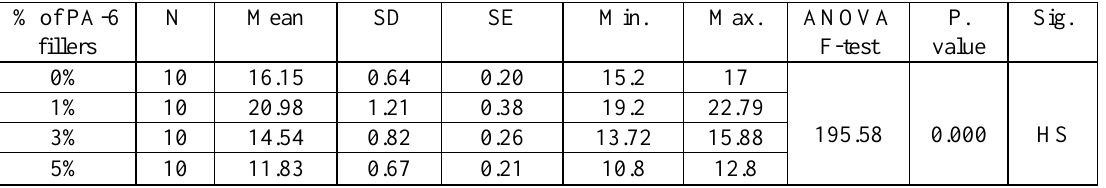
Restorative Dentistry